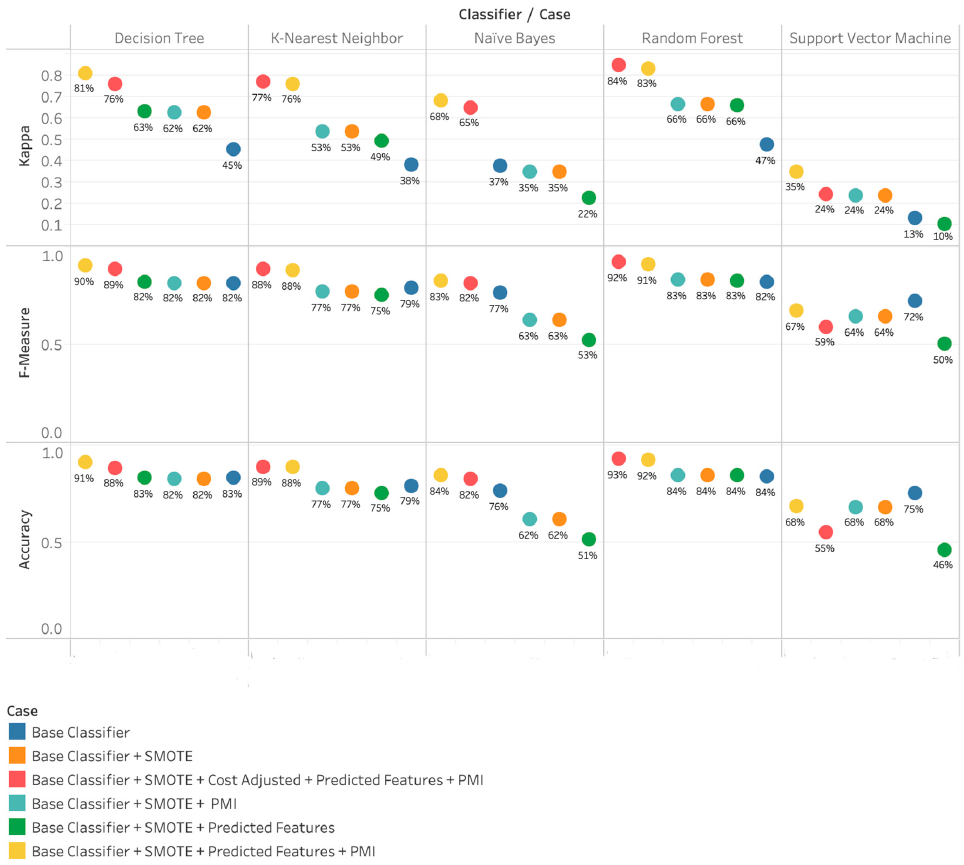
Figure 5. Results achieved with the proposed method. Informatics 2020 , 7 , x